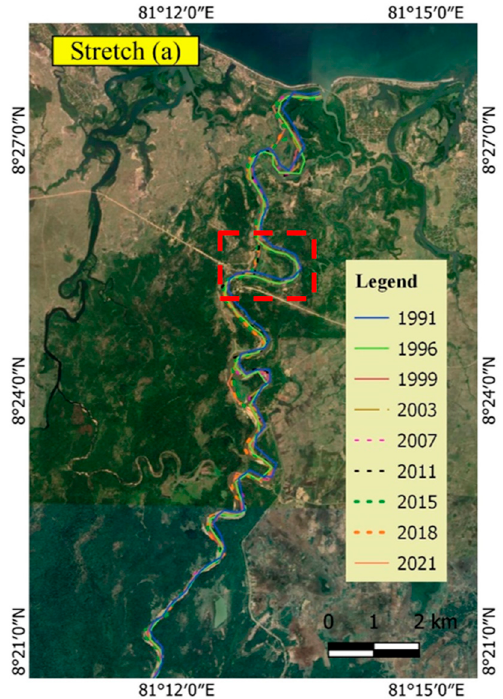
Figure 7 . Temporal variation of river centerline . Figure 7. Temporal variation of river centerline.